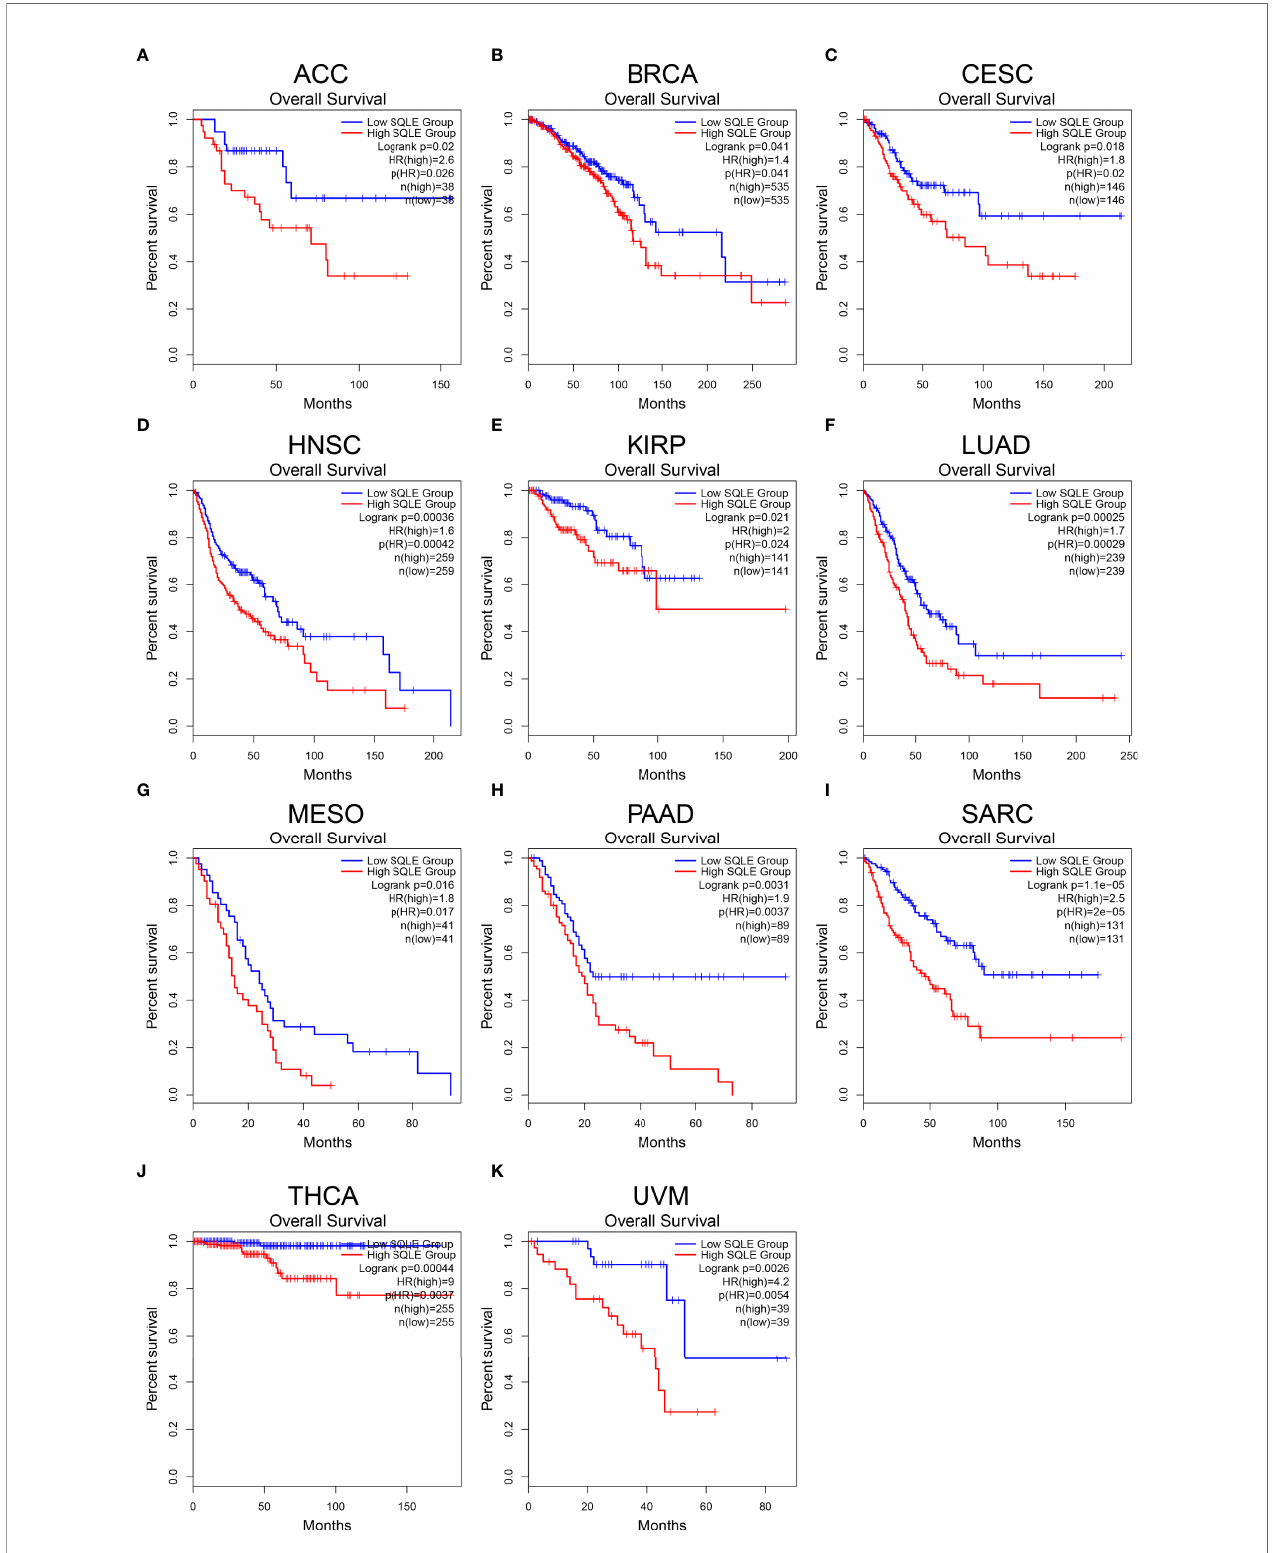
FIGURE 2 | Overall survival (OS) analysis for SQLE in multiple human cancers. (A – K) The OS curves of SQLE in ACC (A) , BRCA (B) , CESC (C) , HNSC (D) , KIRP (E) , LUAD (F) , MESO (G) , PAAD (H) , SARC (I) , THCA (J) , and UVM (K)